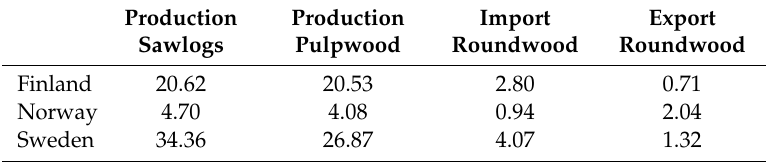
Table 1. Average annual production and trade volumes between 2006 and 2018 (million m 3